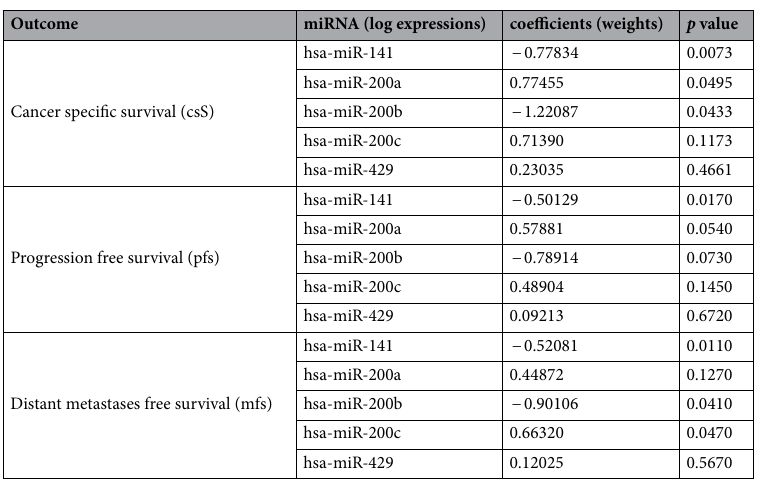
Table 5. Estimated regression coefficients used to compute multiple weighted miRNA